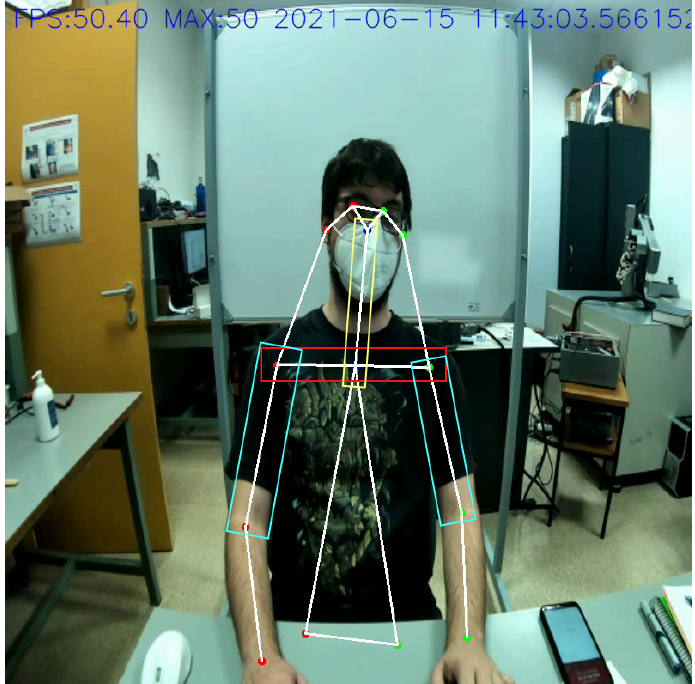
Figure 4. Evaluable parameters from test dataset. Parameters are marked over the CNN output skele- ton with different colors: neck lateral bend (yellow), shoulder alignment (red) and arms abduction (cyan).